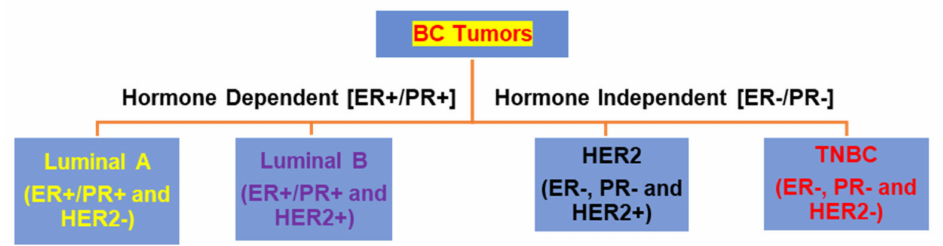
Figure 1. BC tumors have traditionally been classified into four subtypes: Luminal A, Luminal B, HER2, and TNBC. Classification of different tumor subtypes is based on IHC markers for ER, PR, and HER2 expression which are represented by either positive (+) or negative ( − )